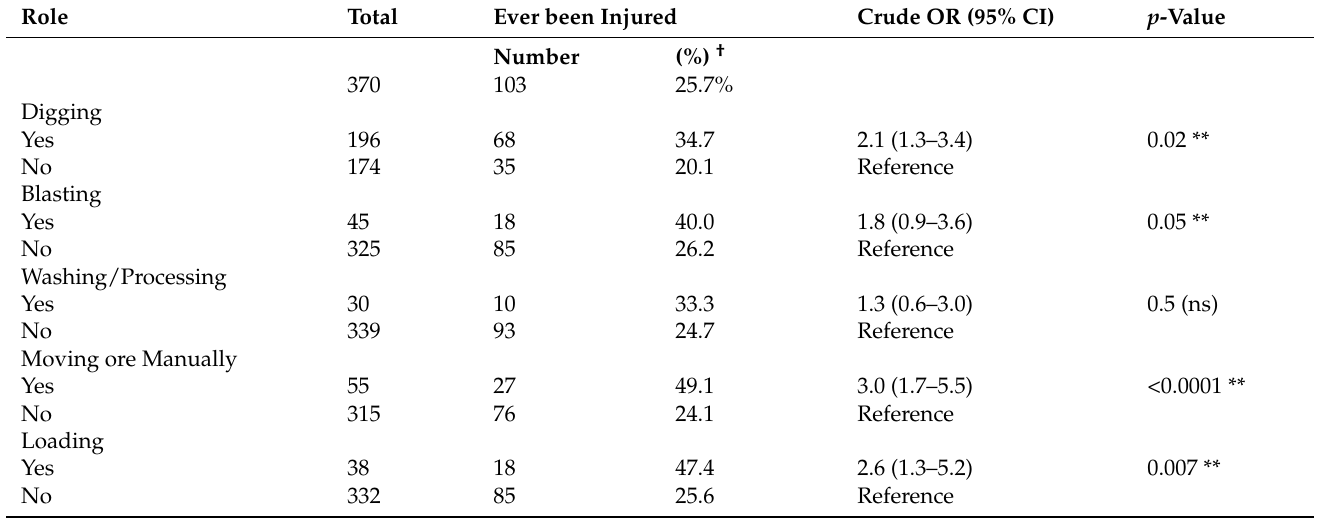
Table 3. Ever-experienced injuries: Percentages of participants who ever experienced injuries and their workplace roles—as reported by artisanal small-scale gold (ASG) miners from Kadoma and Shurugwi in Zimbabwe in the 2020 rainy season, n =